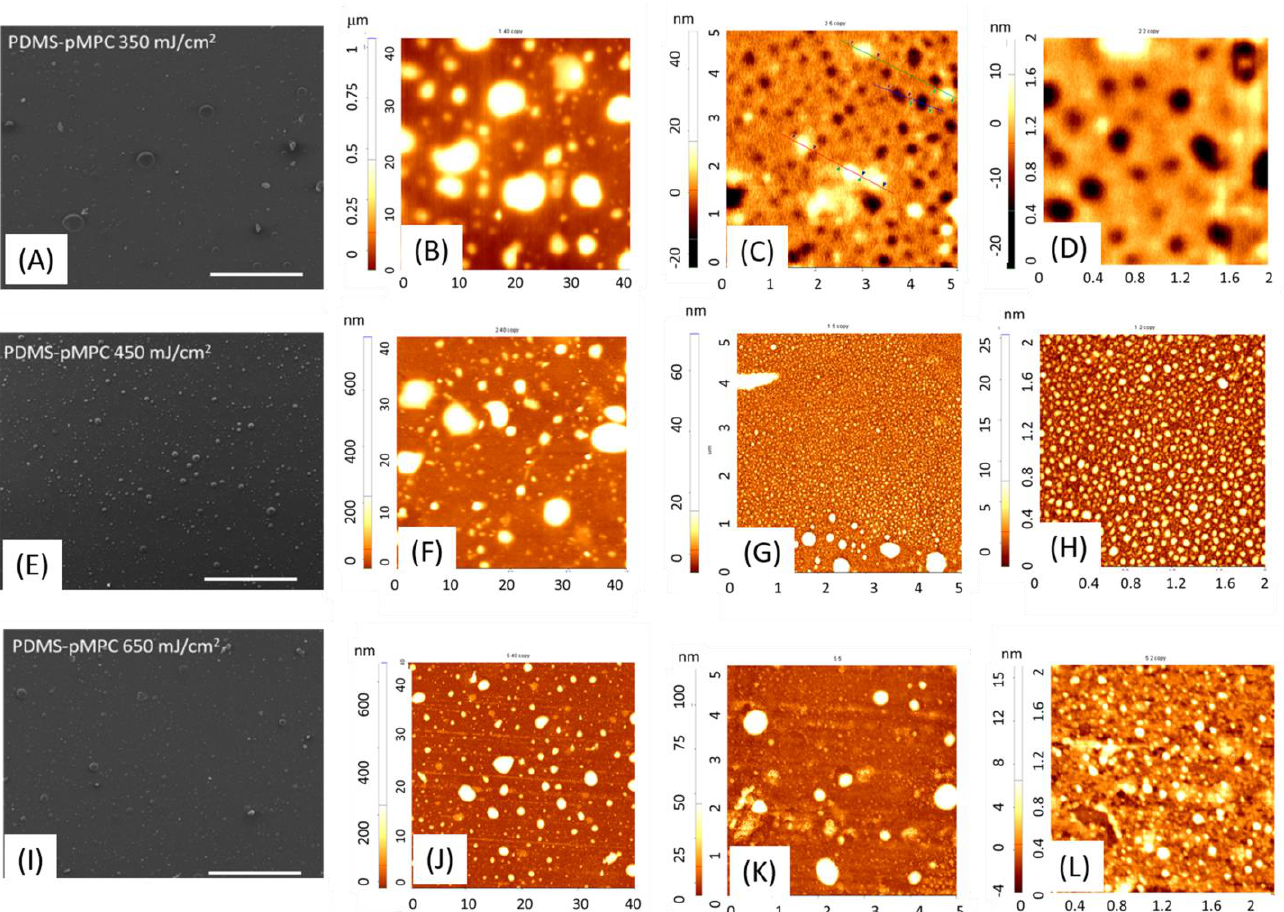
Figure 3. SEM and AFM images of pMPC coatings obtained by MAPLE on untreated PDMS, using fluences of 350 mJ/cm 2 ( A – D ), 450 mJ/cm 2 ( E – H ) and 650 mJ/cm 2 ( I – L ). SEM magnification 1000 × , scale bar SEM images 300 µ m. Scan areas for AFM: 40 × 40 µ m 2 , 5 × 5 µ m 2 and 2 × 2 µ m 2 for the pMPC coatings obtained at fluences of 350 mJ/cm 2 ( B – D ), 450 mJ/cm 2 ( F – H ) and 650 mJ/cm 2 ( J – L ).